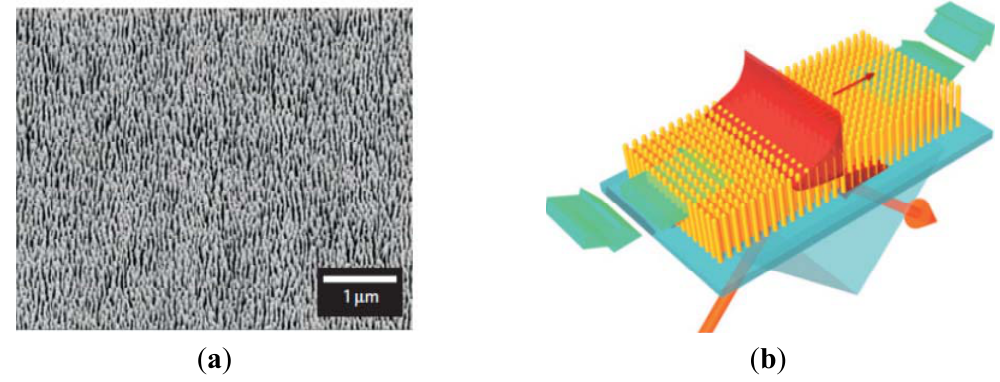
Figure 6. ( a ) Typical scanning electron micrograph of plasmonic nanorod metamaterial and ( b ) Schematic of the attenuated total internal reflection (ATR) measurements and